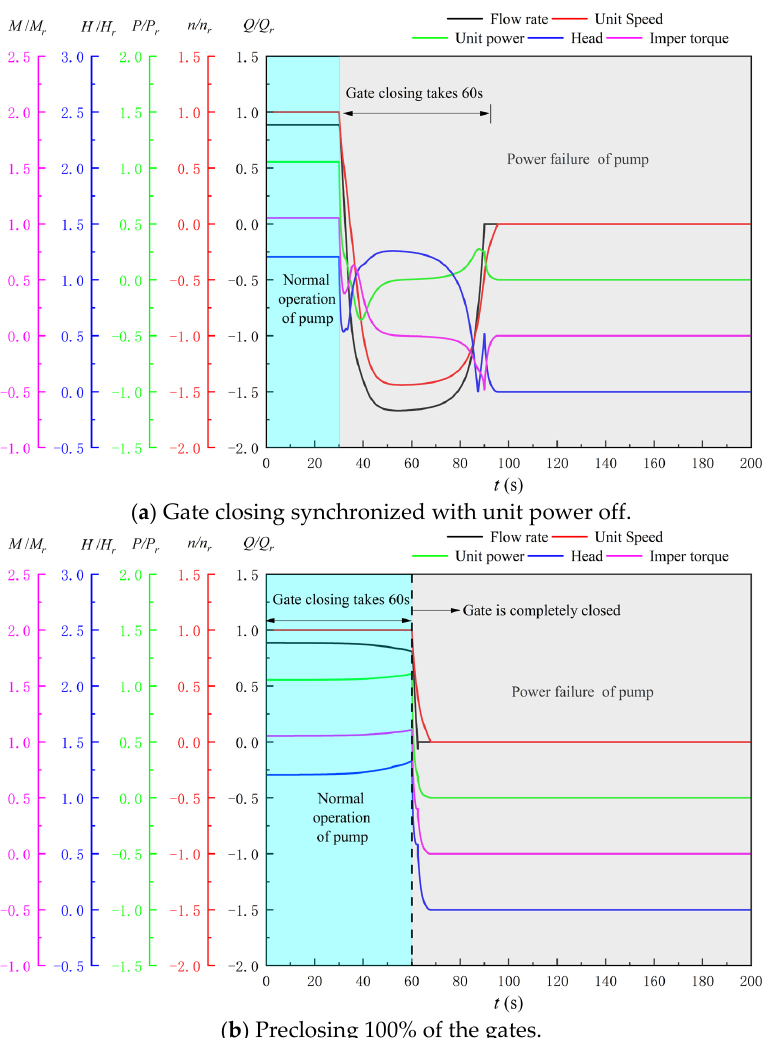
Figure 19. Comparison of the changes of the KCPs of the LAPS with synchronous or advance closing of the gate (TTGC: 60 s).